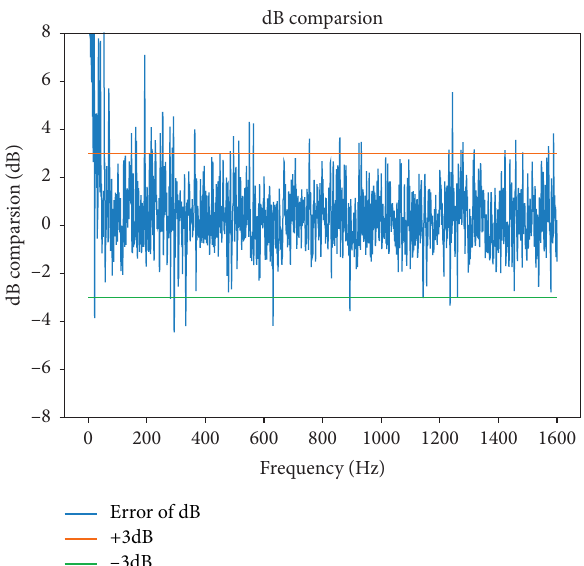
Figure 12: 3 dB error value for the 2 nd response measurement point of the 8 th round before elastic-net